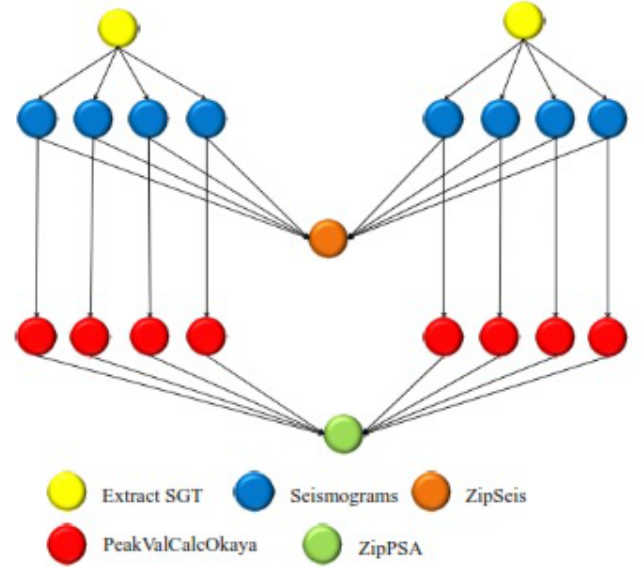
Figure 4. CyberShake